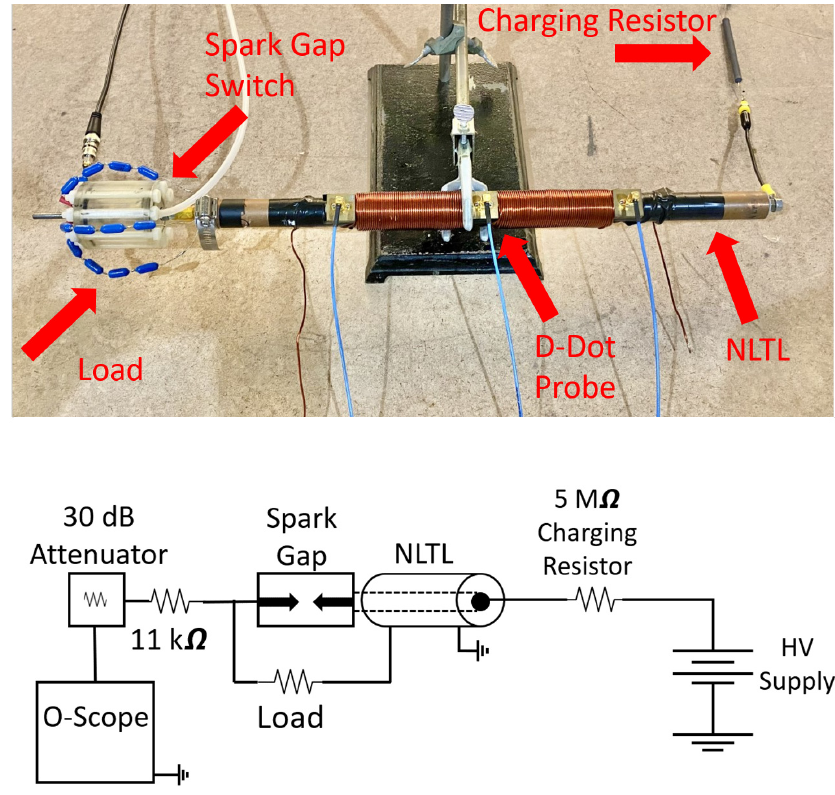
Figure 2. ( Top ) Photograph and ( bottom ) schematic of a 10 Ω NLTL attached to the 3D printed spark gap switch and load. The load consists of four 40 Ω branches of four 10 Ω resistors placed in parallel to achieve a 10 Ω load. Invasive D-dot probes were used to o bserve the pulse waveform as a function of line